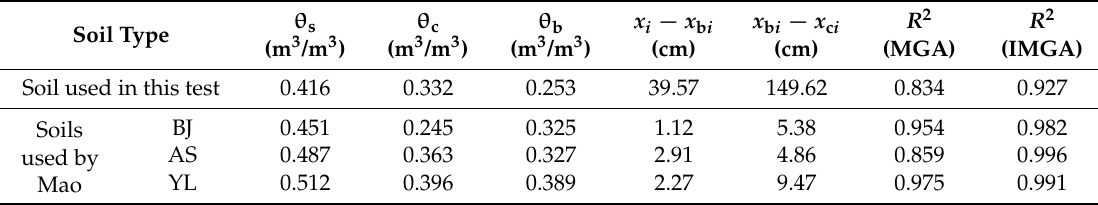
Table 3. Parameter values for different soils. BJ, AS and YL represent soil samples collected in Beijing, Ansai, and Yangling (China).